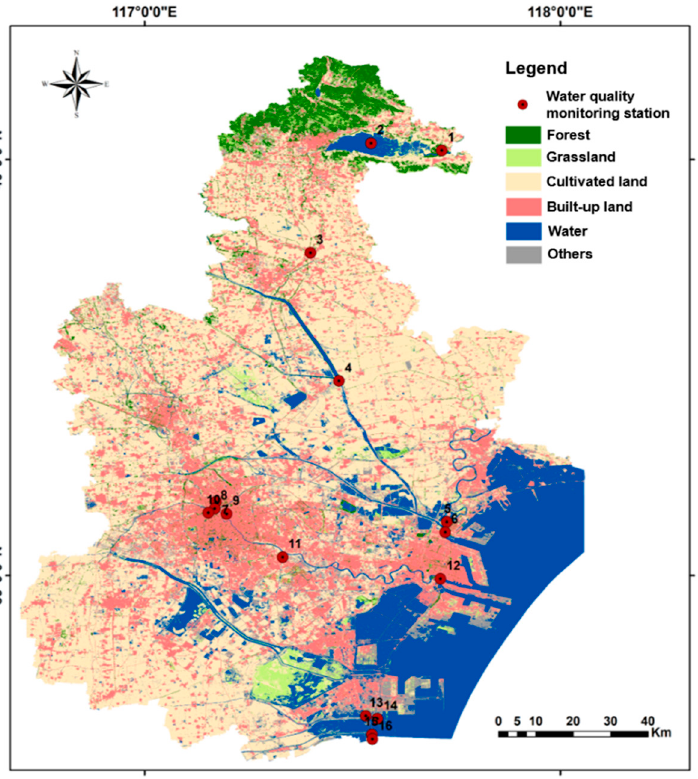
Figure 4. Land use/land cover (obtained from the European Space Agency WorldCover 10 m 2020 product) and the distribution of water quality monitoring stations in Tianjin.